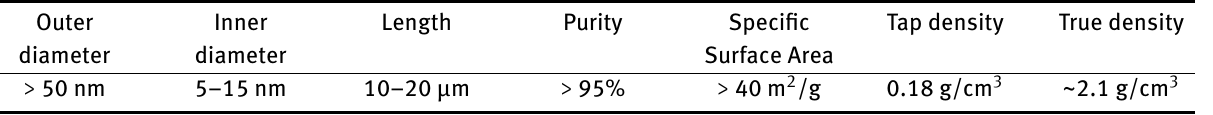
Table 2: Physical properties of MWCNTs. Outer